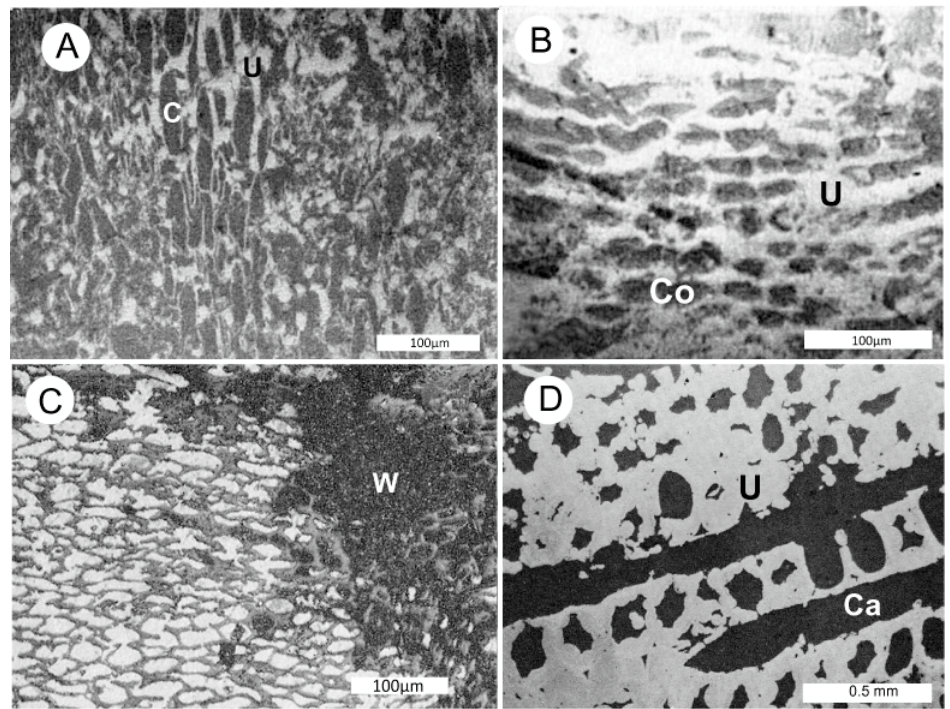
Figure 3. Reflected light optical photomicrographs of polished specimens of uraninite-mineralized fossil wood from San Juan County (UT, USA). ( A ) Wood with calcite ( C ) filling cell lumina and uraninite replacing cell walls. ( B ) Coffinite (Co) filling lumina, uraninite (U) replacing cell walls. A , B from Mi Vida Mine, Lisbon-Big Indian Wash District [9]. ( C )Carbonized wood fragment partially mineralized with chalcopyrite and uraninite. Chalcopyrite (white) has filled lumina, uraninite (gray) has replaced cell walls. W = unmineralized carbonized wood. Happy Jack Mine, White Canyon District [10]. ( D ) Coalified wood from Mi Vida Mine, with cell walls replaced by uraninite (U), open fractures and lumina interior regions mineralized with calcite (Ca)[11].